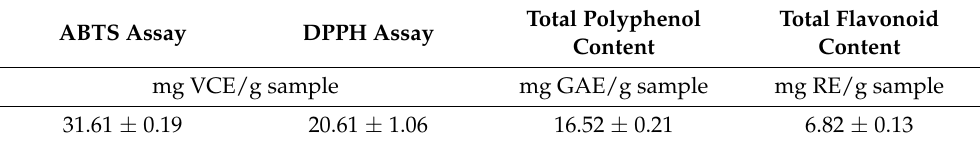
Table 1. Radical scavenging capacity and phytochemicals in sword bean